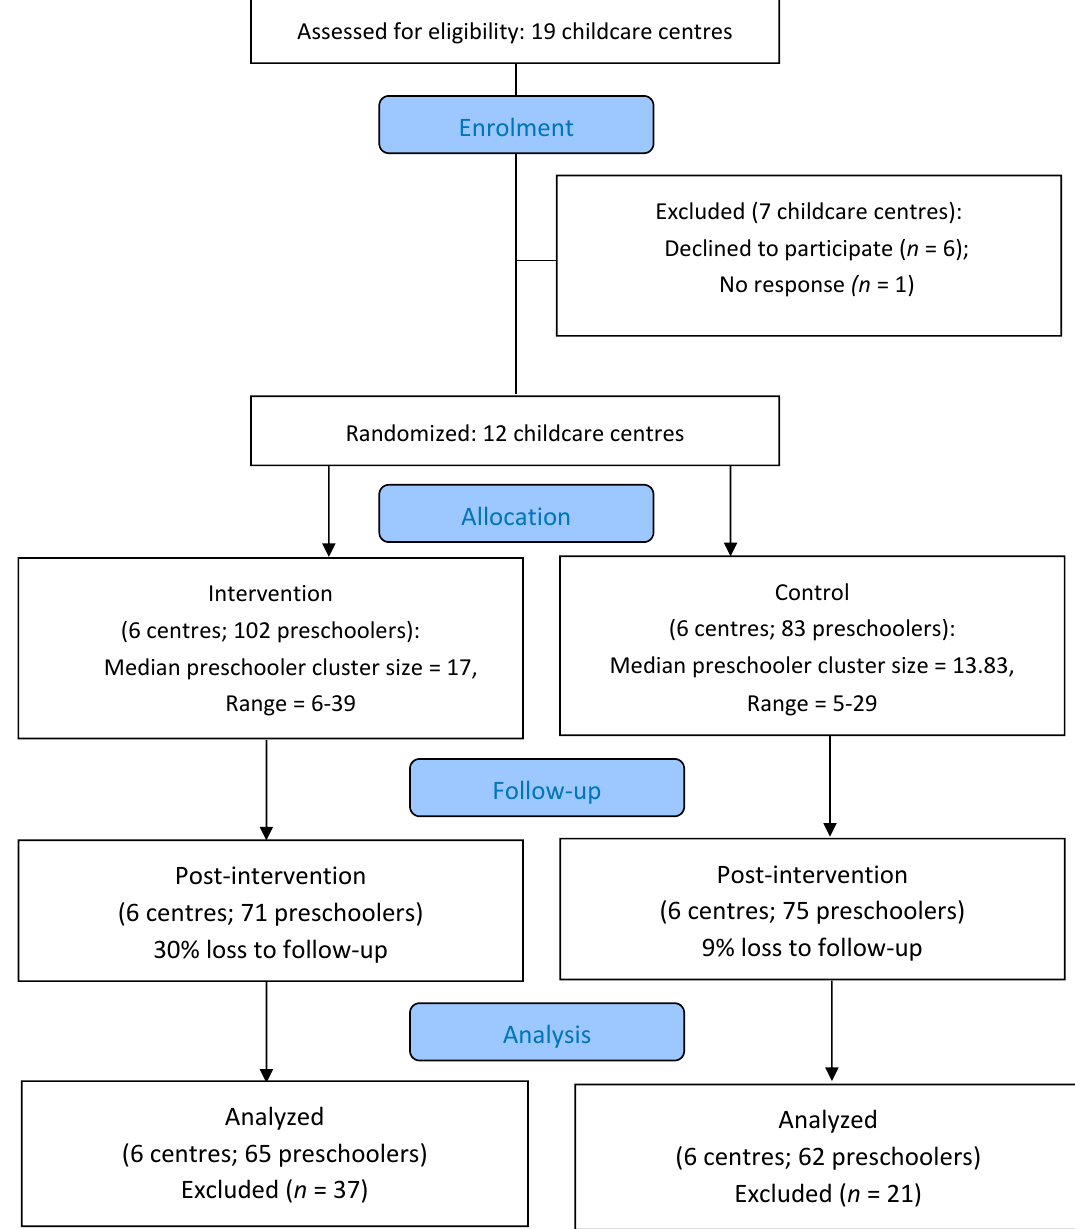
Figure 1. CONSORT Flow Diagram of the SPACE Study Extension Participation Note . No centres were lost to follow-up or dropped out of the intervention. Preschoolers were excluded due to: inadequate wear-time ( n = 30), absent during data collection ( n = 12), withdrawal from childcare ( n = 14), or lost device ( n = 2).